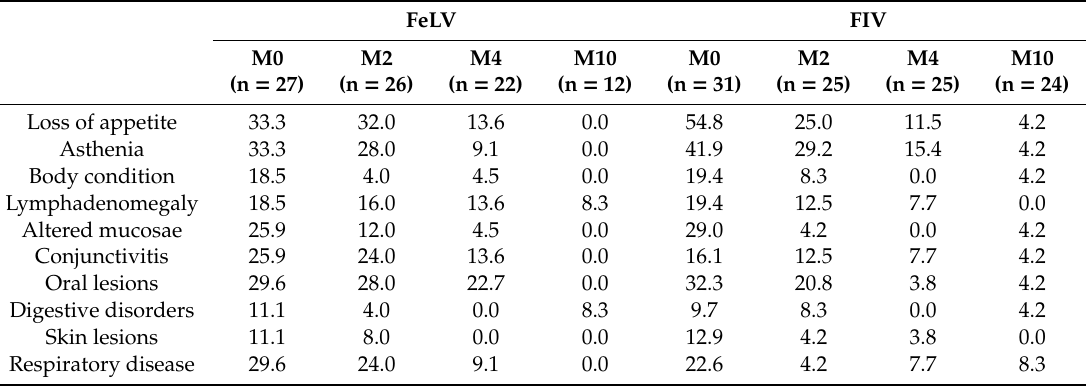
Table 3. Percentage in which the different clinical signs in FeLV+ and FIV+ cats treated with rHuIFN- α were observed. M0, beginning of treatment; M2, two months (±15 days) after beginning of treatment (mid-treatment); M4, four months (±15 days) after beginning of treatment (end of treatment); M10, 10 months (±2 months) after beginning of treatment.